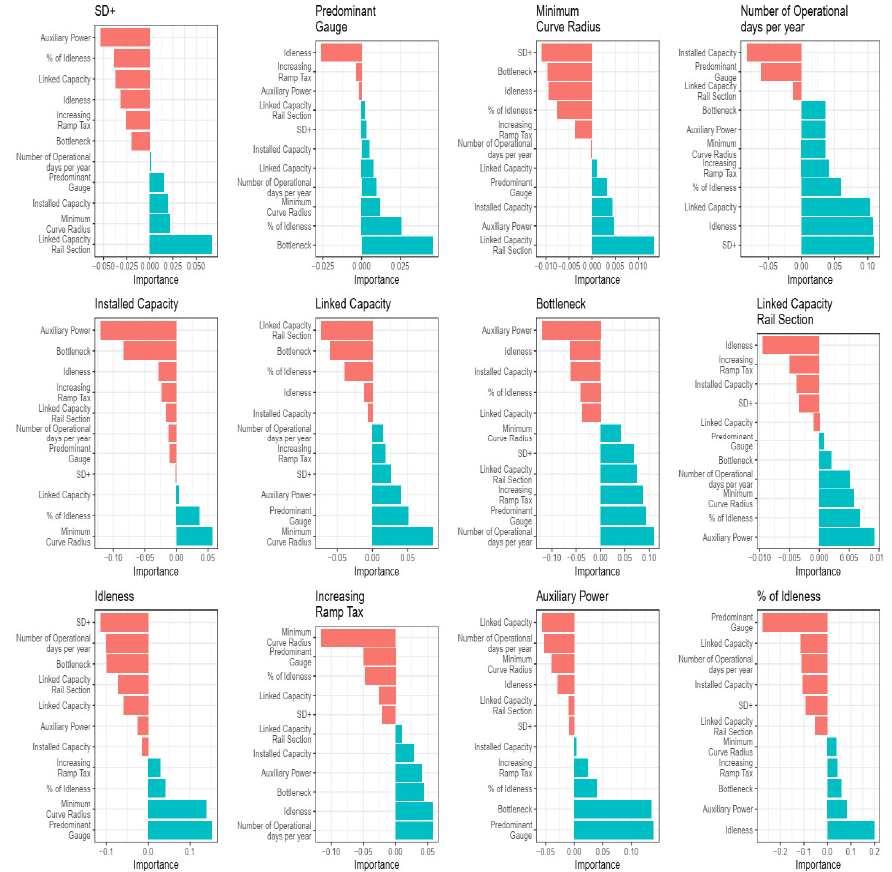
Figure 9. Results for Olden’s sensitivity analysis in terms of signs and relative importance for mod- els (1)–(12).